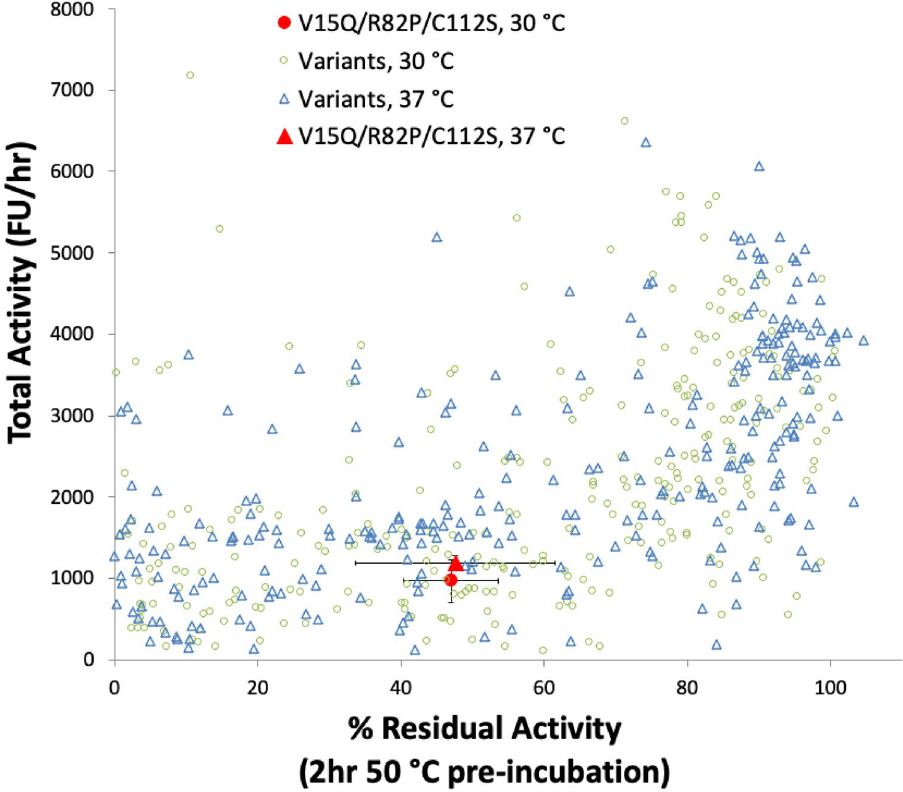
Figure 5. Relationship between total activity and the residual activity after a 2-h heat inactivation at 50 °C, for the 321 unique EK L variants obtained from retest assays. Error bars of variant V15Q/R82P/C112S are standard deviations from twelve repeat